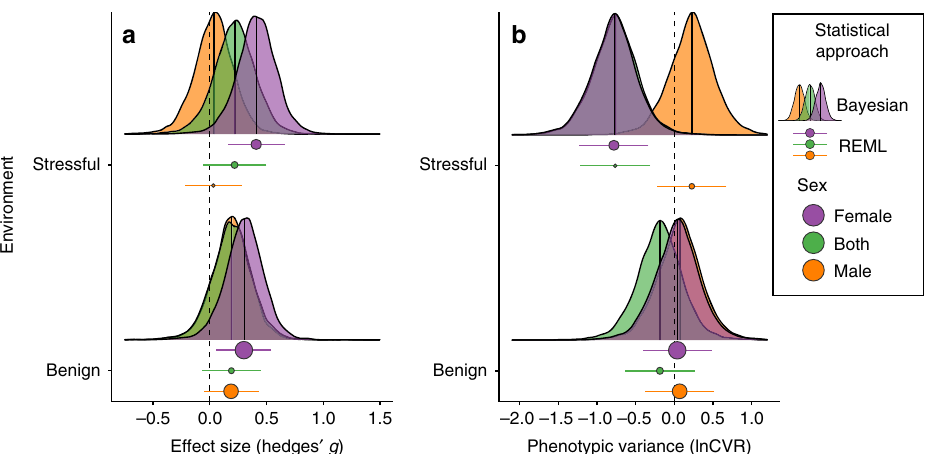
Fig. 2 The roles of environmental stress and sex. a Sexual selection tends to increase the population mean values of fi tness traits, especially for female traits and for populations living under stressful conditions. b Under stressful conditions, sexual selection tends to reduce the phenotypic variance in fi tness traits, especially for traits measured in females or mixed-sex individuals. The points with error bars show the mean effect sizes and their 95% con fi dence intervals (CIs), determined from a meta-regression fi t using restricted maximum likelihood (REML); the point sizes are proportional to the number of effect sizes (see Supplementary Tables 14 and 18). Results from Bayesian meta-regression are shown as posterior prediction density curves, with vertical lines indicating the median. Data used for generating this fi gure are available in the Source Data fi